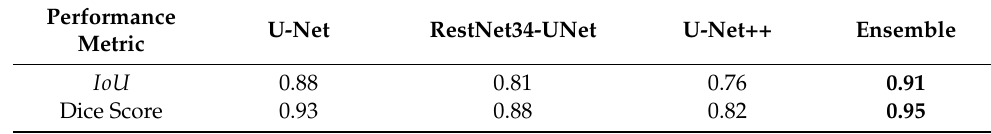
Table 1. The evaluation results of three neural networks and the ensemble-based model.